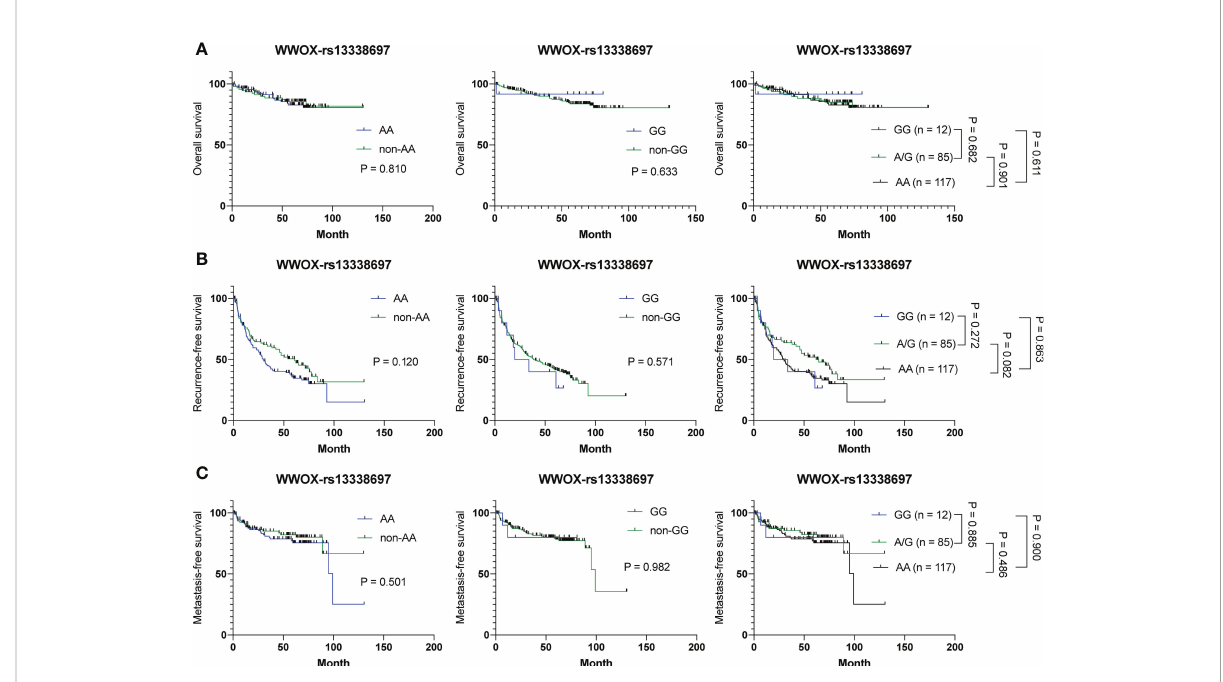
FIGURE 5 Analysis of the WWOX -rs13338697 genotypes in association with OS, RFS, and MFS in all 214 HCC patients receiving surgical resection. Kaplan- Meier analysis of (A) OS, (B) RFS, and (C) MFS of subgroups of patients with HCC strati fi ed by the WWOX -rs13338697 genotypes. P values were obtained by log-rank test, and < 0.05 was considered signi fi